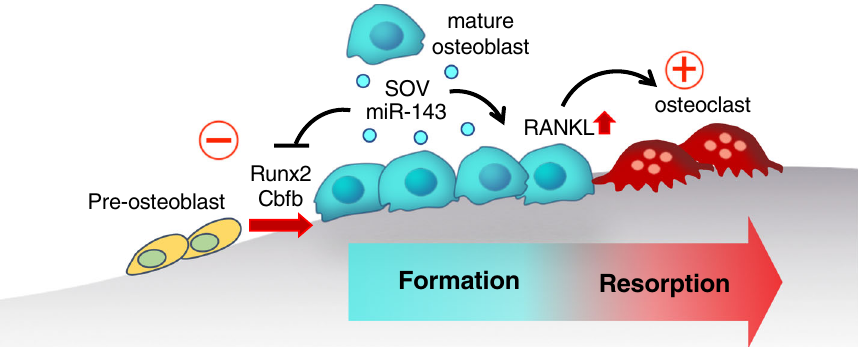
Fig. 6 Graphical abstract of the role of small osteoblast vesicles in bone remodeling. Interactions among mOBs via SOVs inhibit osteoblastic bone formation and stimulate osteoclast formation, thus switching from the bone formation phase to the bone resorption